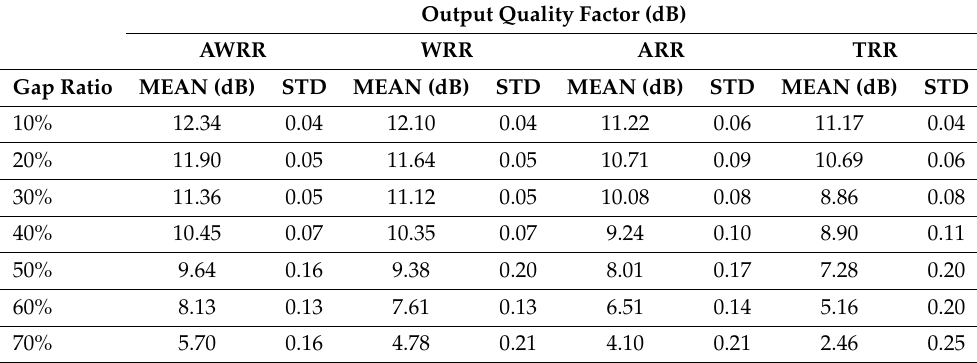
Table 1. Mean and standard deviation of the quality of interpolation for each method for different gap-ratio inputs.